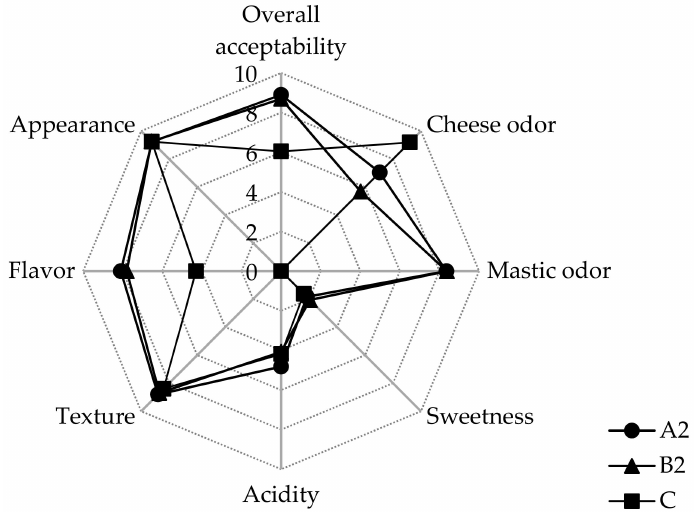
Figure 3. Sensory evaluation of whey beverages containing an immobilized biocatalyst on P. terebinthus resins (A2), P. terebinthus resins (B2), and control whey beverages at the 30th day of storage (4 ◦